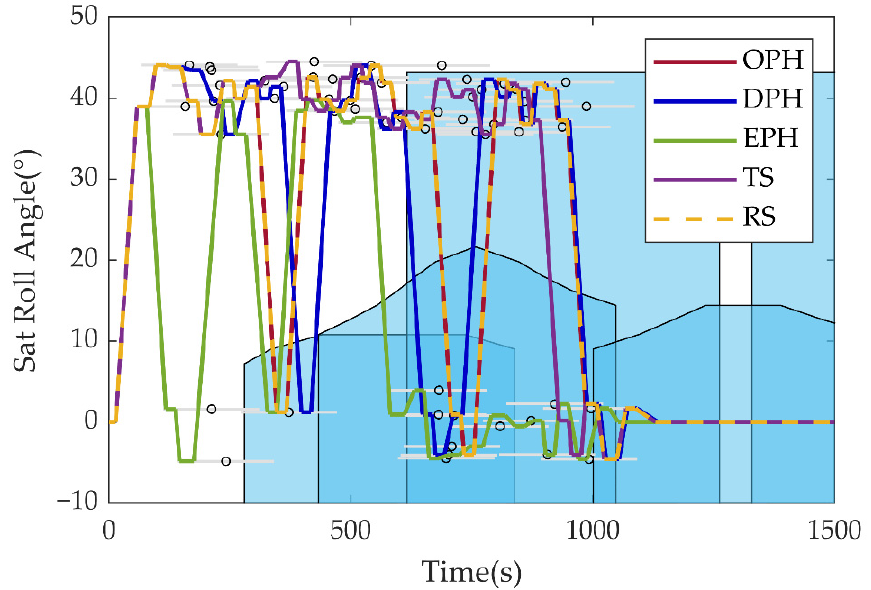
Figure 8. Targets selection and observation path diagram of a single condition in the first group.